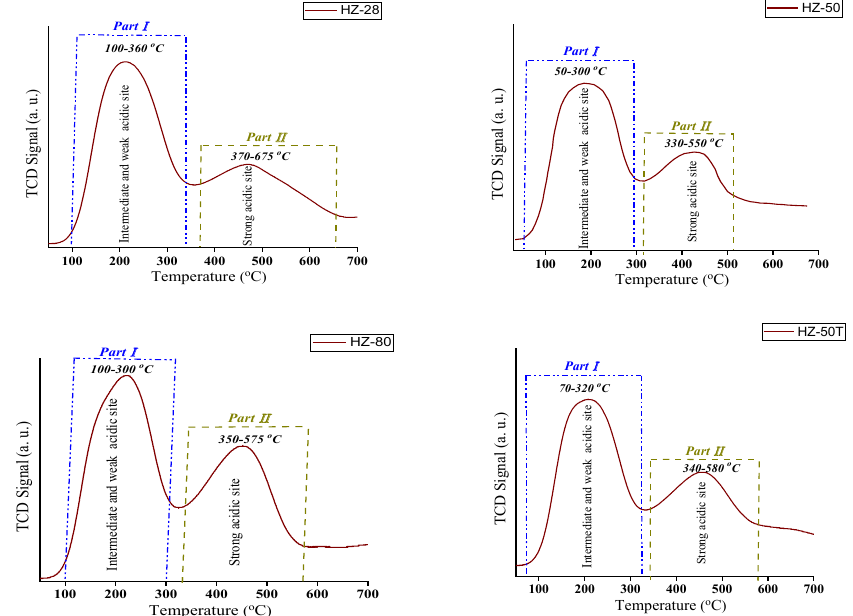
Fig. 3. NH -TPD profiles of the hierarchical HZSM-5 zeolites with different Si/Al ratios. 3 Fig. 3. NH 3 -TPD profiles of the hierarchical HZSM-5 zeolites with different Si/Al ratios.